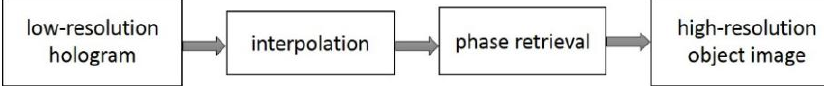
Figure 10. Schematic diagram of the data interpolation method.